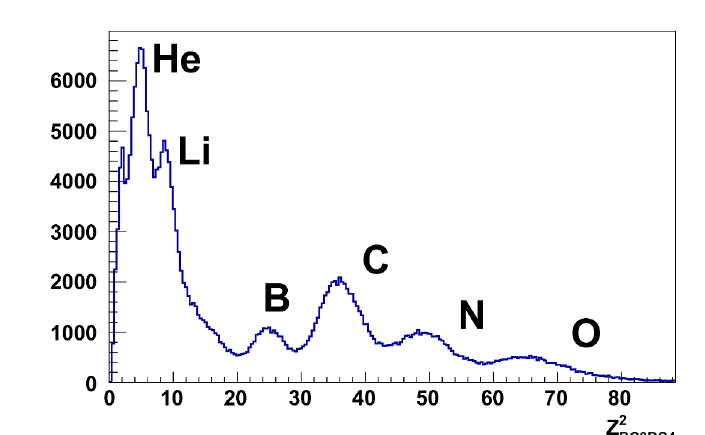
Figure 3. The square of the particle charge after the beam-target